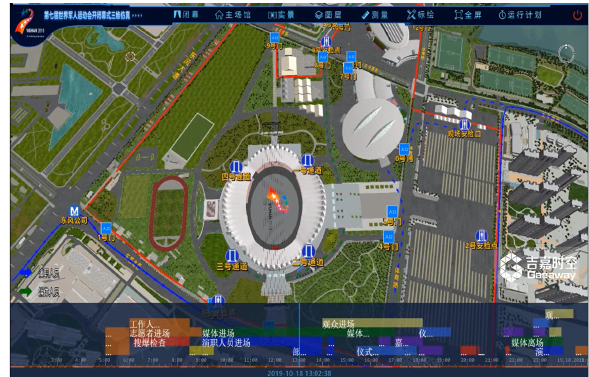
Figure 8 . The 3D simulation rehearsal system for the opening and closing ceremonies of Wuhan World Military Figure 7. Schematic diagram of indoor multi-expression model construction